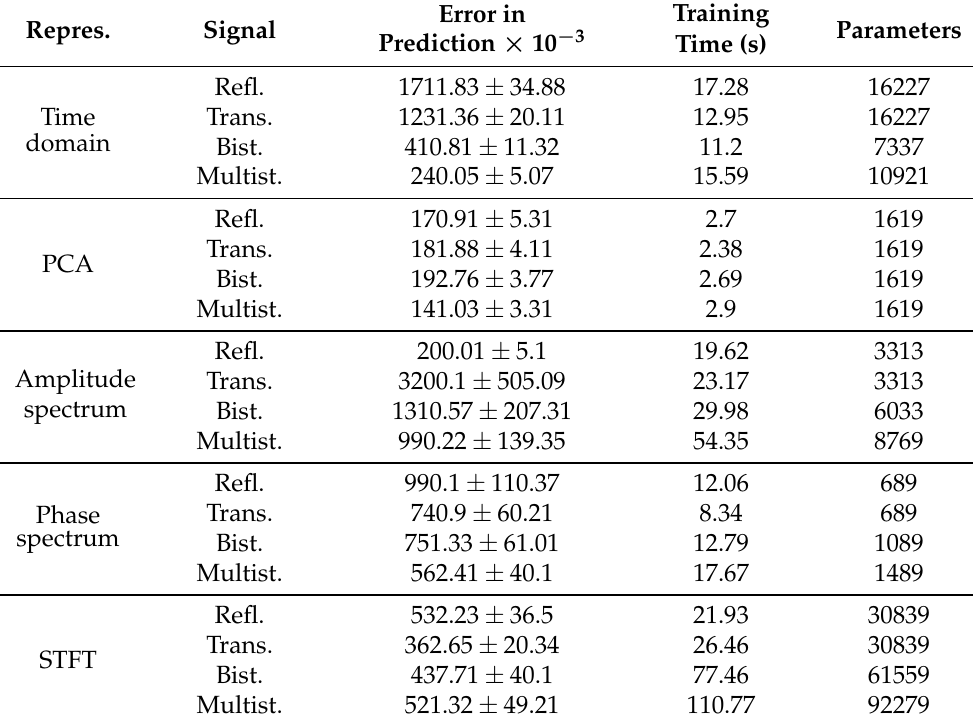
Table 3. Dielectric loss tan δ parameter estimation with different representations. Repres. Signal